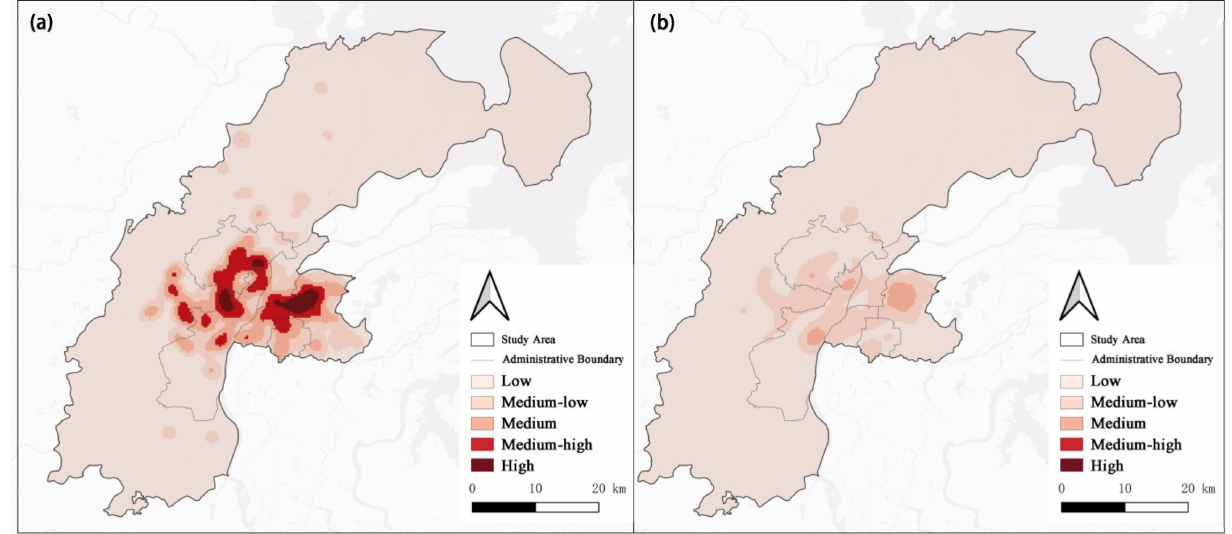
Figure 8. The density map of outdoor sports venues based on KDE: ( a ) pre-epidemic; ( b )